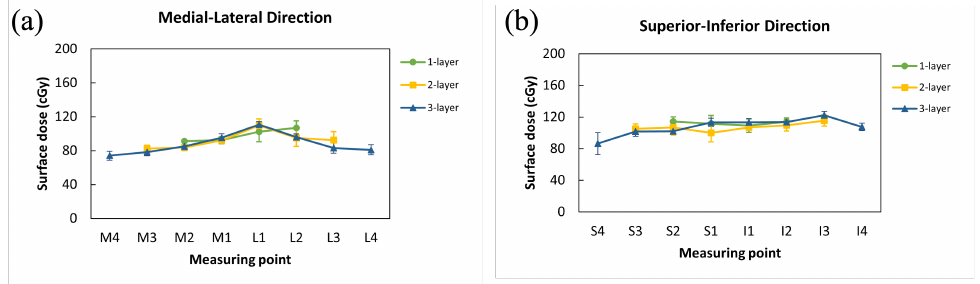
Figure 5. The dose distribution among three different breast accessories. ( a ) Medial-lateral direction and ( b ) superior-inferior